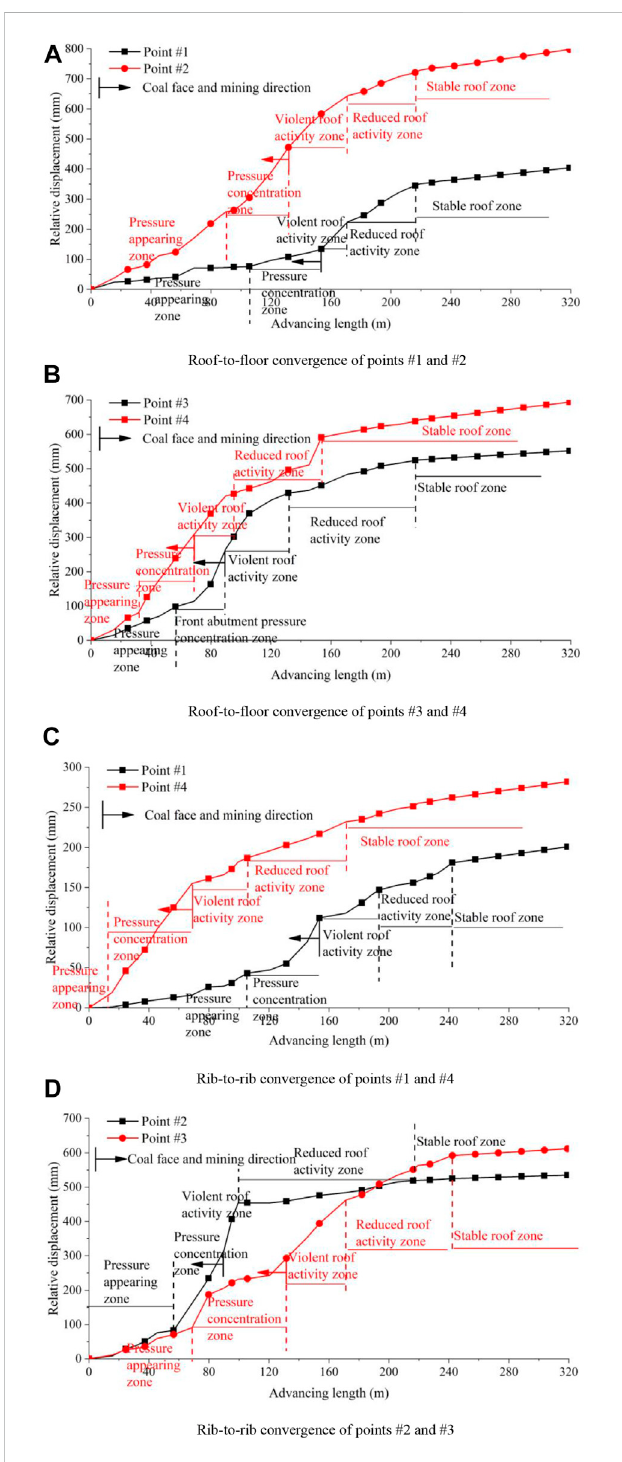
FIGURE 2 Relative displacement variation characteristics of the roof-to- fl oor and the rib. (A) Roof-to- fl oor convergence of points #1 and #2. (B) Roof-to- fl oor convergence of points #3 and #4. (C) Rib-to-rib convergence of points #1 and #4. (D) Rib-to-rib convergence of points #2 and